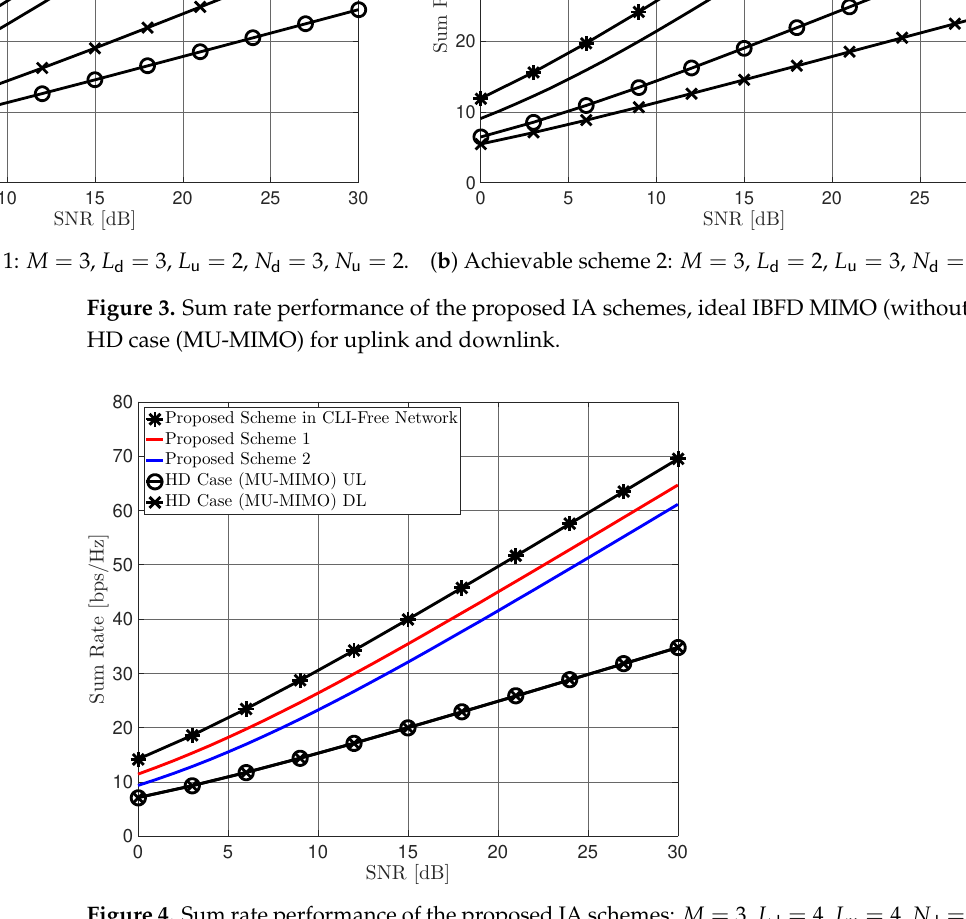
Figure 4. Sum rate performance of the proposed IA schemes: M = 3, L d = 4, L u = 4, N d = 3, N u =